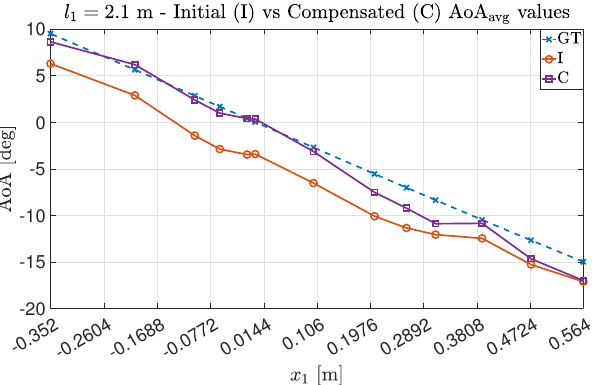
Figure 10. Average AoA estimation values for Exp#1 before and after the